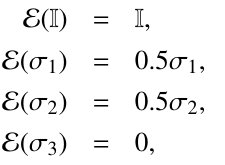
Figure 6: Action of the completely positive (CP) pancake map. The Bloch ball (outer ball of unit radius) is shown in white. The image is plotted in